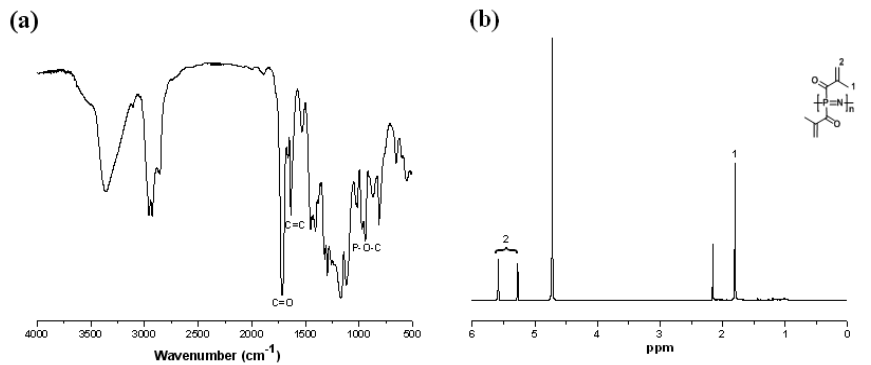
Figure 2. ( a ) FT-IR and ( b ) 1 H-NMR spectra of PBMAP.